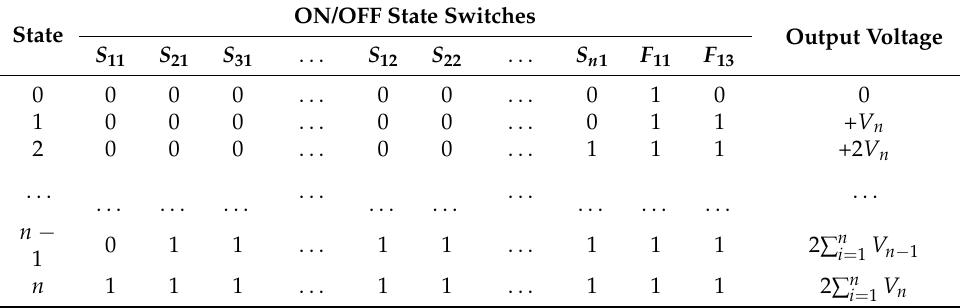
Table 2. Switching Sequence of the Proposed Symmetric Topology.